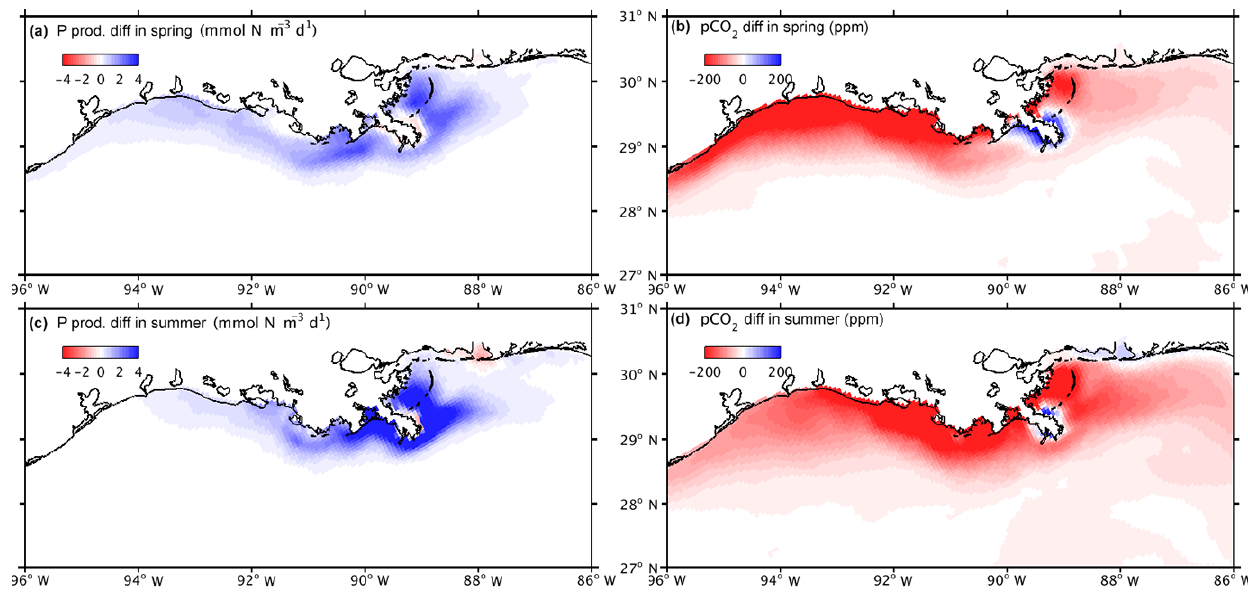
Figure 12. Differences in model-simulated primary production and p CO 2 between the 2004–2010 and the 1904–1910 periods (2005–2010 minus 1905–1910 seasonal mean condition). For (a) and (c) blue color indicates increased primary production during 2004–2010; for (b) and (d) red color indicates reduced p CO 2 during